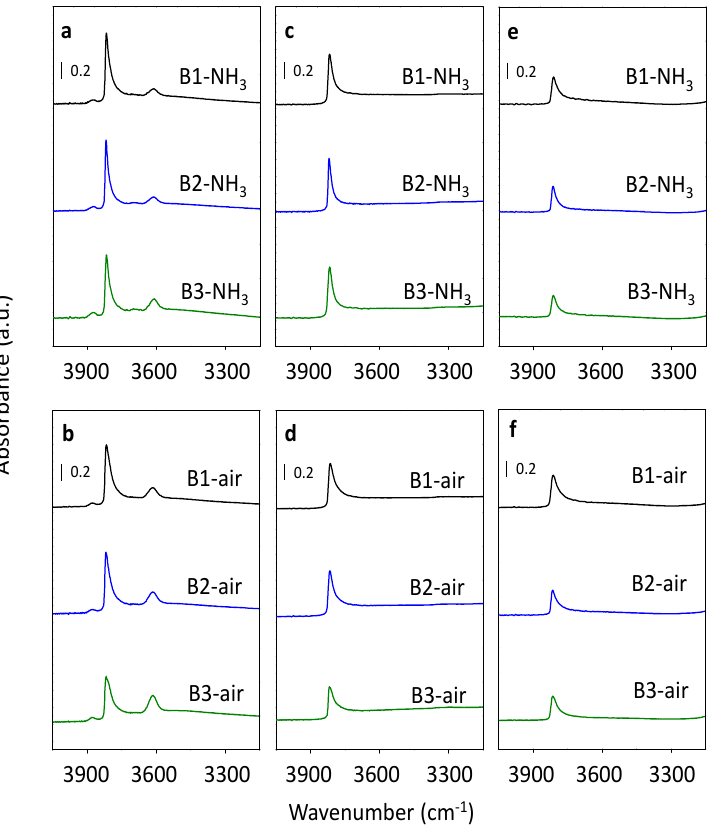
Figure 7. The e ff ect of d 3 -acetonitrile ( c , d ) and pyridine ( e , f ) adsorption in the region of OH vibrations of B1–B3 evacuated samples calcined in ammonia ( a ) and in air ( b